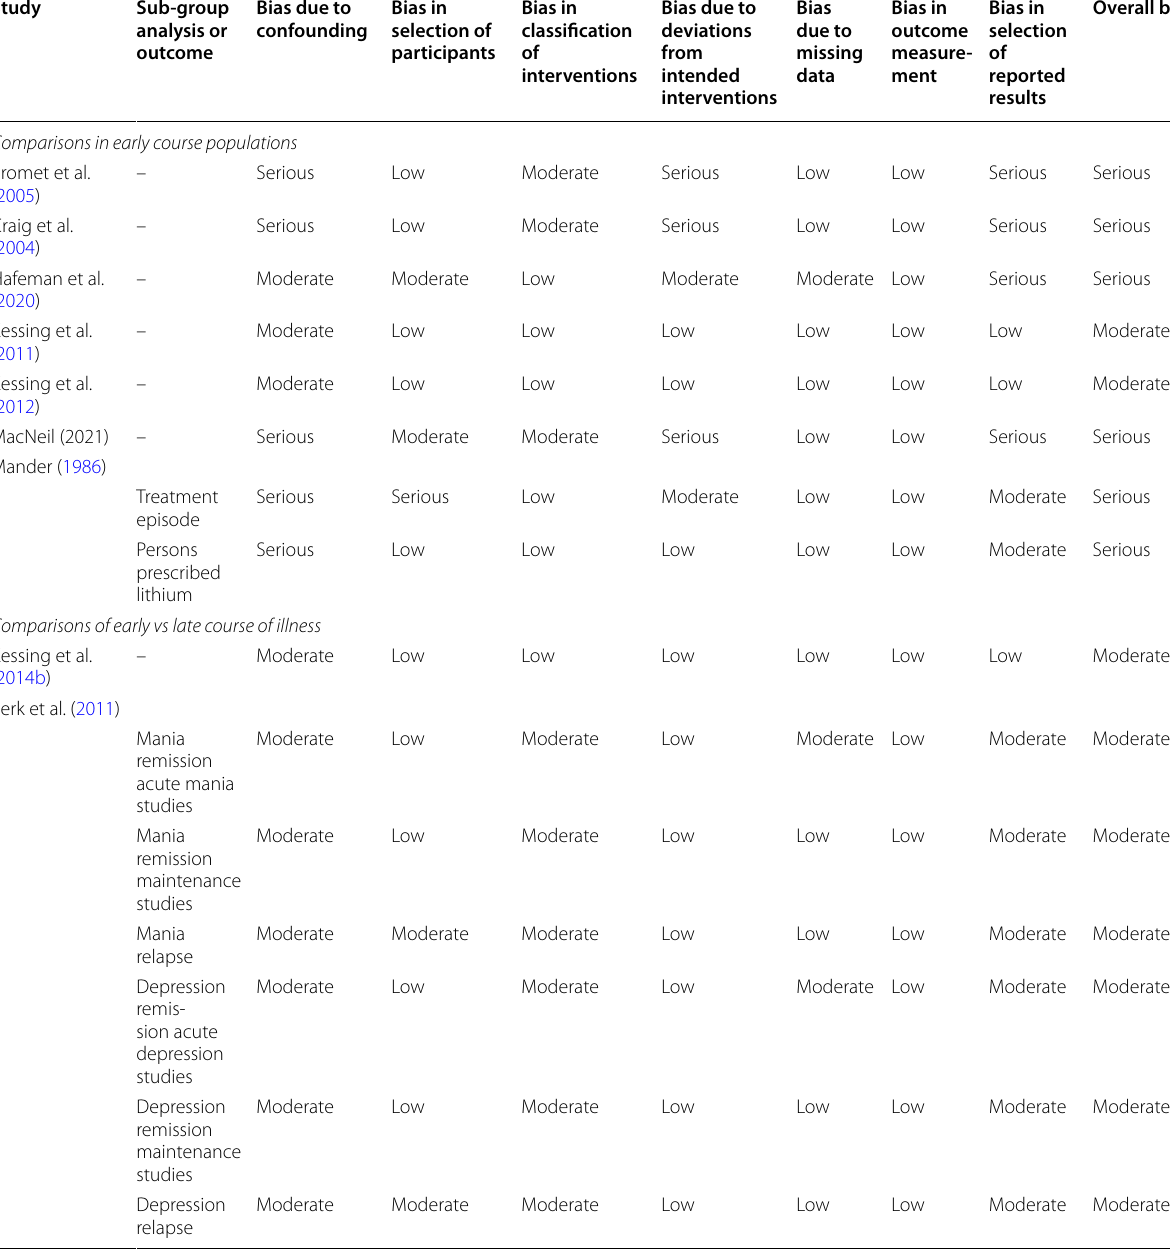
Table 3 Risk of bias from included non-randomised